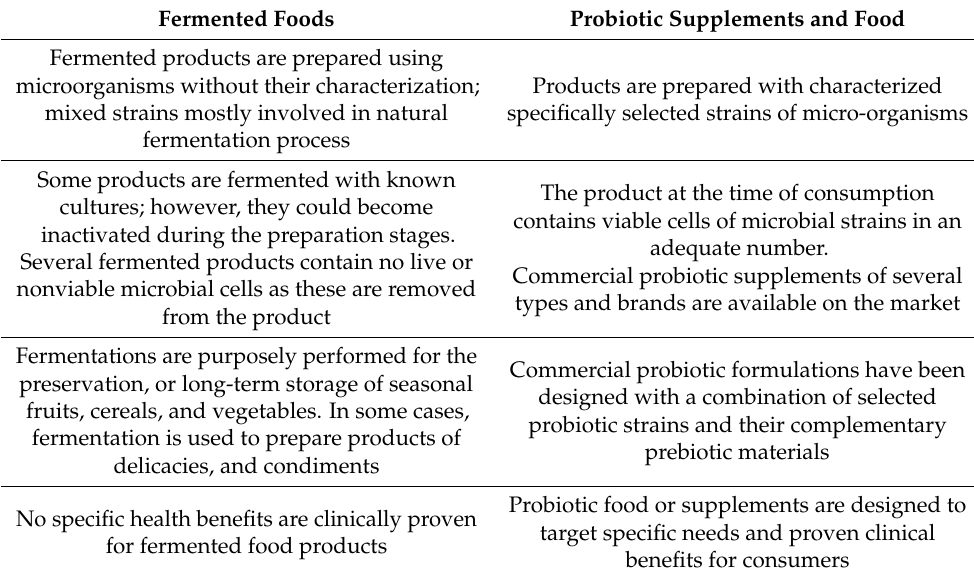
Table 4. Main differences between probiotic supplements and fermented